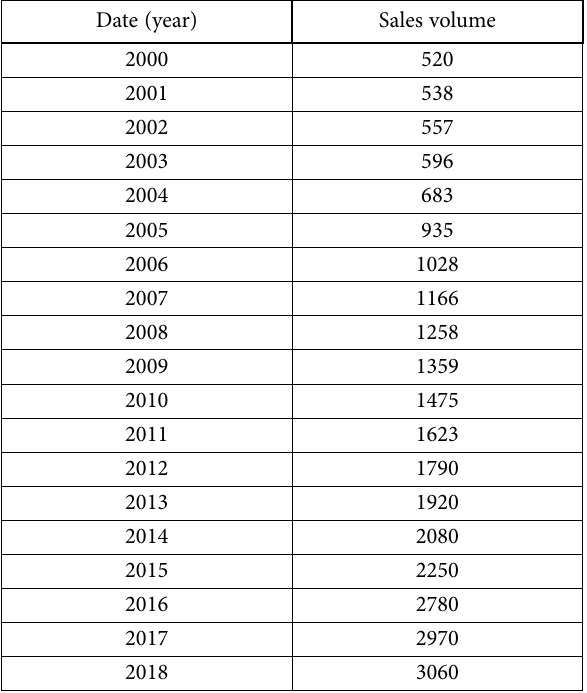
Table 1. Sales volume of green tea in Nanjing from 2000 to